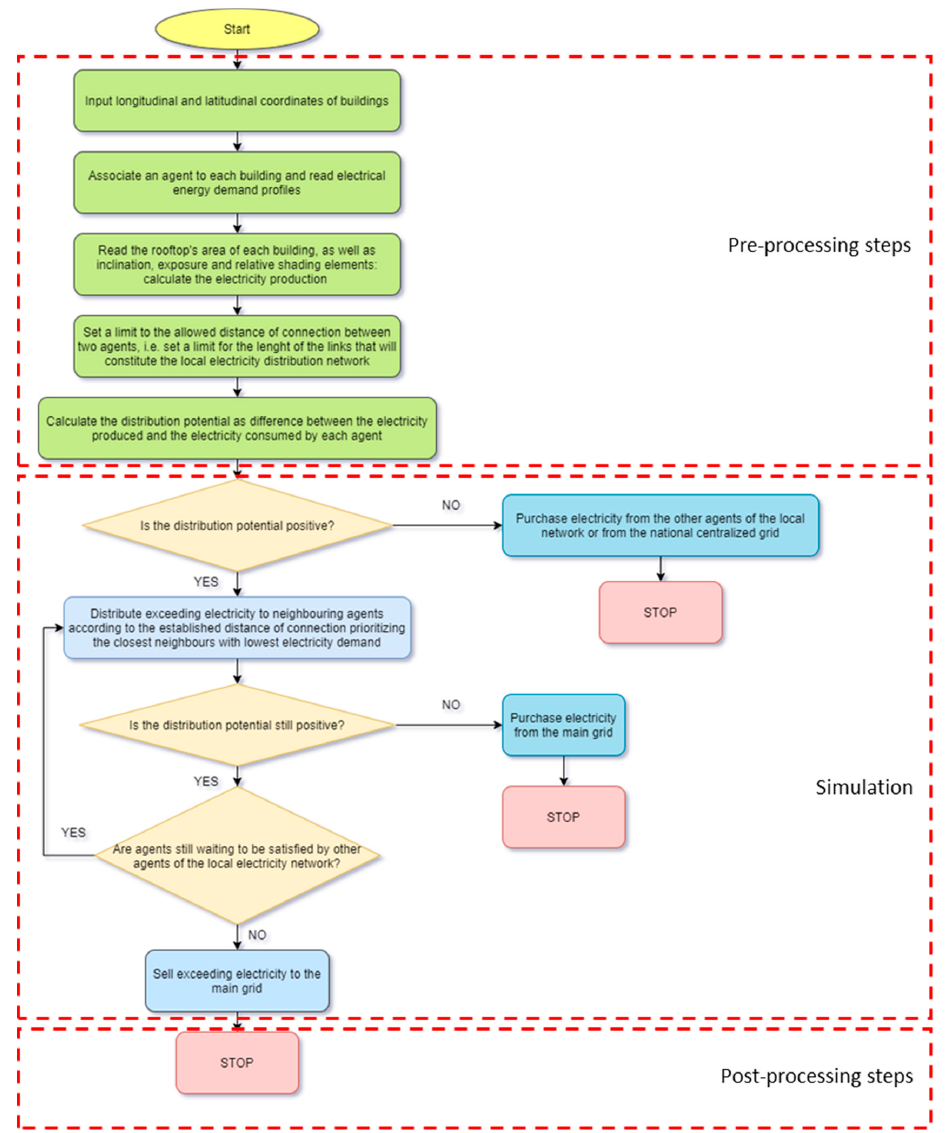
Figure 1. Flowchart of the proposed agent-based model.